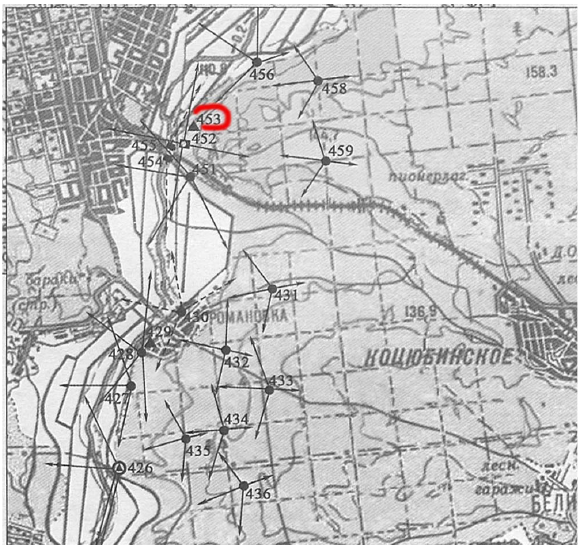
Figure 2. Tangential distortion curve